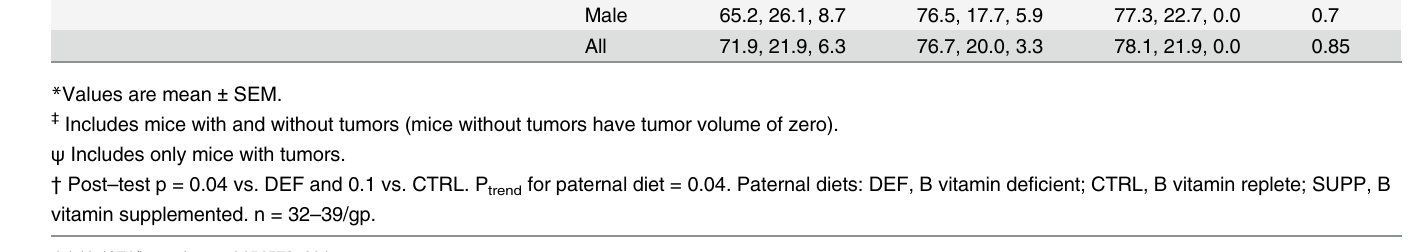
or average tumor volume in offspring did not differ between groups (Table 4). Offspring gen- (81.25 vs. 45.8%, Chi-square p = 0.0002), tumor multiplicity (1.28 vs. 0.54 tumors/mouse, p < 0.0001) and tumor volume (70.6 vs. 18.9 mm 3 /mouse, p = 0.001) than female mice.